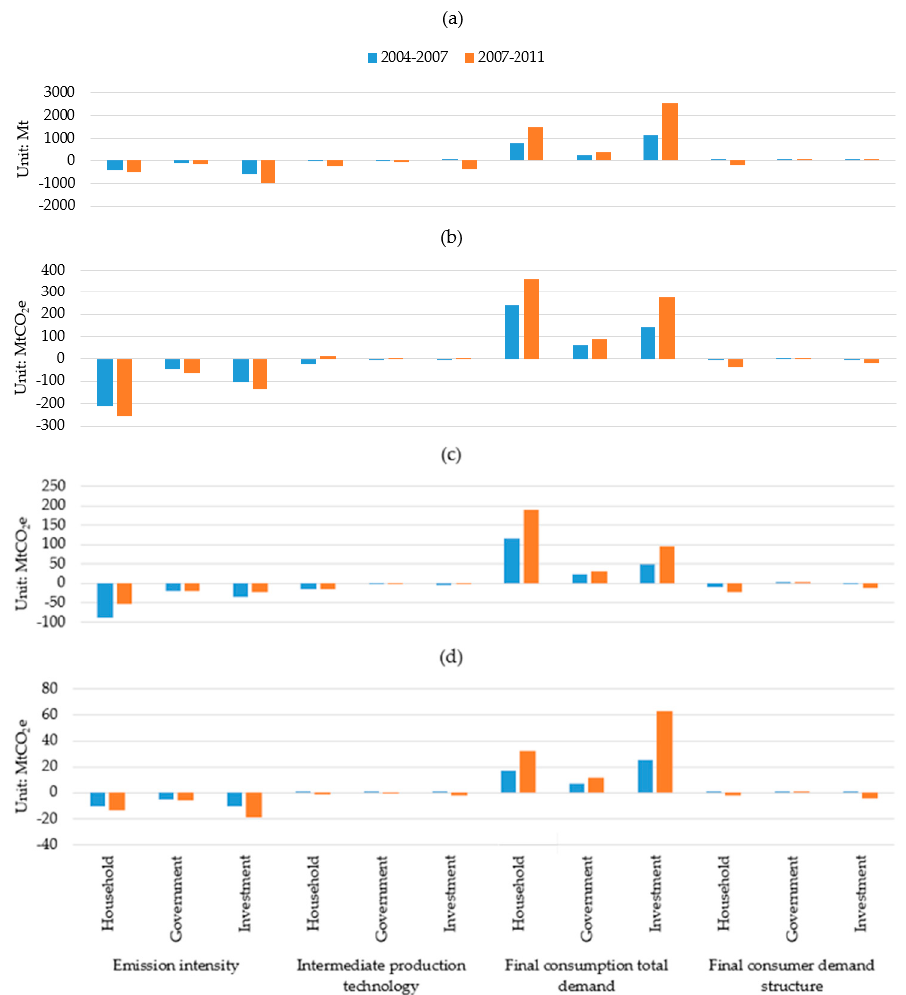
Figure 3. ( a ) China's indirect consumption-based CO 2 emissions by SDA; ( b ) China's indirect consumption-based CH 4 emissions by SDA; ( c ) China's indirect consumption-based N 2 O emissions by SDA; ( d ) China's indirect consumption-based F-gases emissions by SDA.